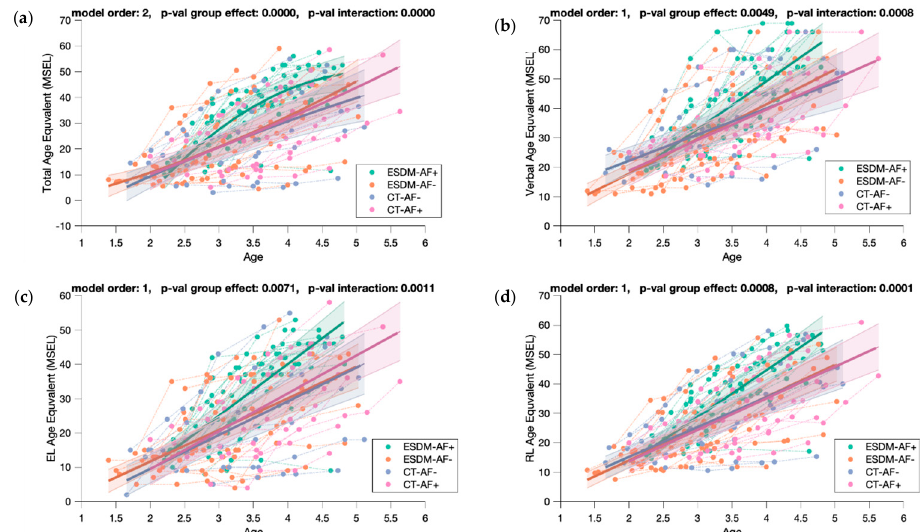
Figure A8. Mixed model regression analysis for the MSEL Total Age Equivalent ( a ), Verbal Age Equivalent ( b ), Expressive Language Age Equivalent ( c ), and Receptive Language Age Equivalent ( d ) for 211 longitudinal recordings from 71 young children with ASD (2.82 ± 0.60 years old) with lower or higher social orienting at baseline and who either received an early and intensive intervention ( ESDM-AF+; ESDM-AF- ) or community treatment ( CT-AF +; CT-AF- ). The group-level trajectory (bold line) is derived from mixed-effect modeling [43–45]. The 95% confidence interval is indicated by the colored bands around the estimated group-level trajec- tory.